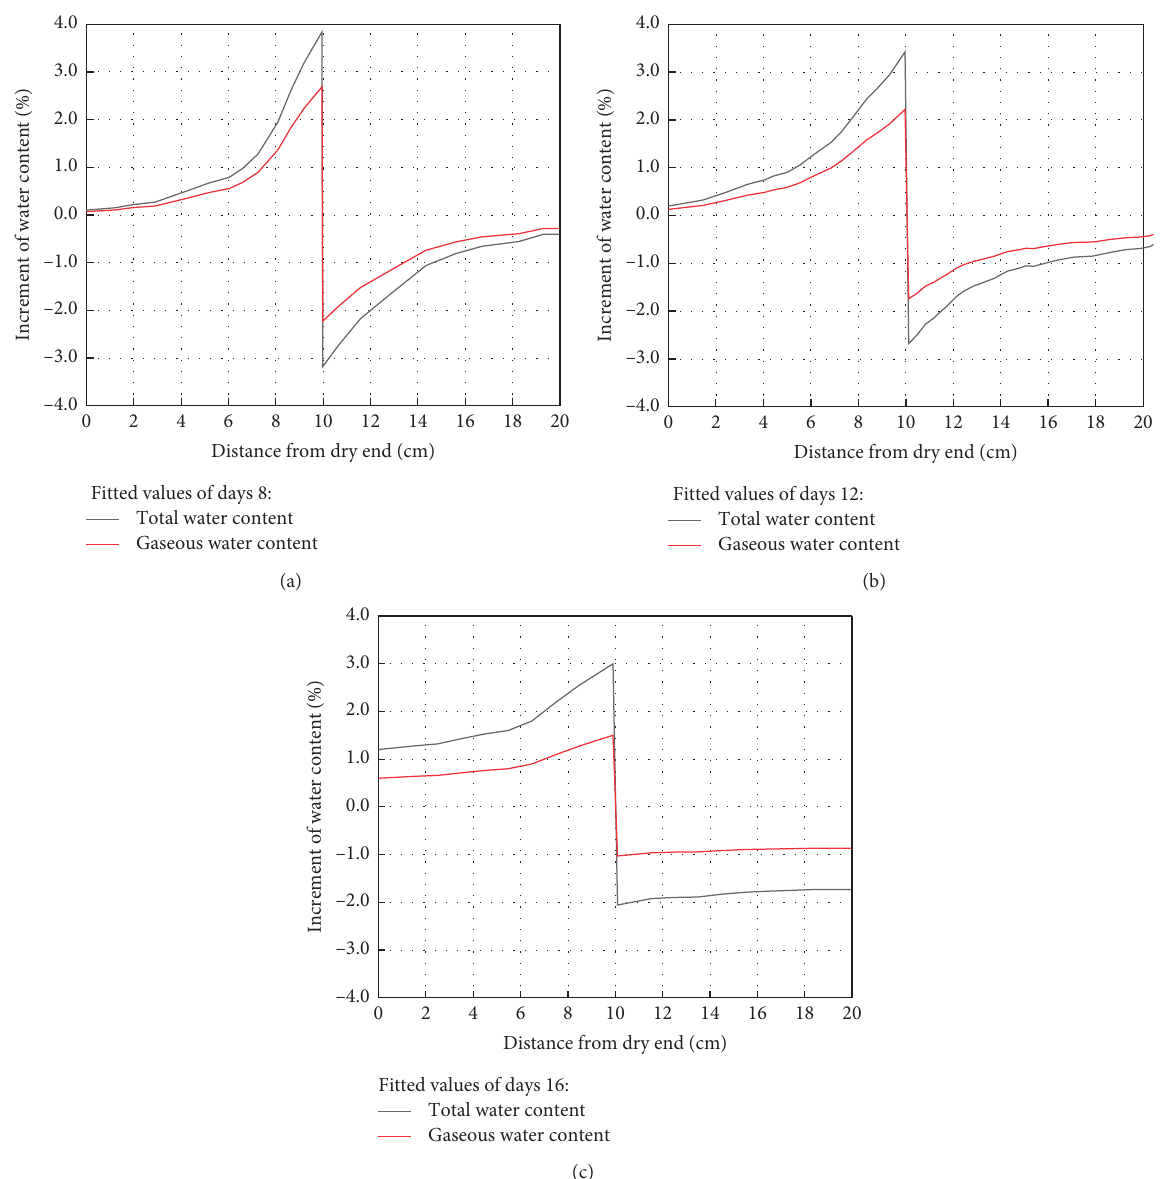
Figure 10: Fitted values of increase in total gaseous water content of water migration after days (a) 8, (b) 12, and (c)